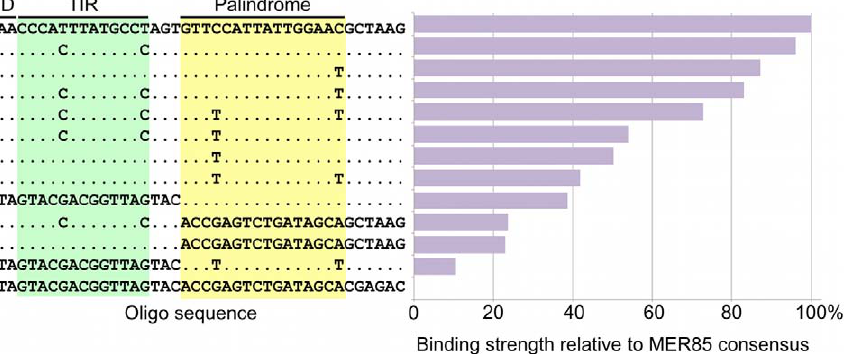
Figure 5. Mutations in the palindromic region reduce PGBD3 transposase binding affinity for MER85s. Synthetic 42 bp MER85 fragments were mixed with purified PGBD3 or no protein, and used for an electrophoretic mobility shift assay. The binding affinities of the transposase for synthetic 42 bp fragments were normalized to the Repbase consensus sequence (100%) and a scrambled sequence (0%). Only sequence mismatches are displayed; positions that match the Repbase consensus are indicated by periods. TSD, target site duplication; TIR, terminal inverted repeat.